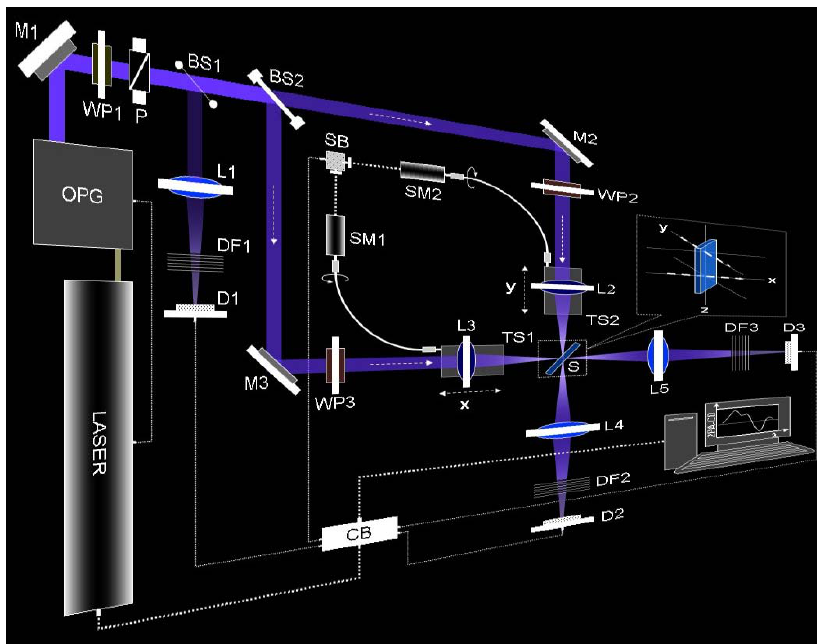
Figure 6. Experimental setup of the double L-scan. Between the laser system and mirror M1 more optical elements such as converging and diverging lenses, pinholes, optical filters, polarizers and waveplates were placed for beam expansion, collimation, spatial filtering, energy attenuation and polarization control. The power of the pump beam is attenuated and linearly polarized using a combination of an achromatic zero-order broadband (spectral range ≈ 400–700 nm) half-wave plate (WP1) and a broadband Glan polarizer (P). The beam splitter BS1 (10/90) is employed to constantly monitor a weak portion of the incoming laser light as an energy reference on a silicon detector (D1). The strongest fraction of the laser is separated into two identical beams using a broadband (50/50) beam splitter (BS2). The final alignment of the two beams is controlled by means of two broadband aluminum mirrors (M2 and M3). The polarization state of the incident beams after all reflective elements, is achieved by placing two achromatic zero-order broadband quarter-waveplates (400–700 nm), WP2 and WP3, before two achromatic convergent lenses, L2 and L3 (focal distance = 100 mm, w0 ≈ 11 μ m). L2 and L3 are moved simultaneously, with identical displacement x = y, and in the same direction on two individual translation stages (TS1 and TS2). TS1 and TS2 are simultaneously translated by coordinating two step-motors, SM1 and SM2, using a synchronization box (SB). Due to the experimental geometry, S is placed at a 45° angle with respect to the incident beams propagation axes, giving an effective path length equal to 1.4 mm (1 mm thickness cell). The two incident beams are approximately 1 cm apart on the vertical axis (inset) and both are parallel to the table. After the sample, L4 and L5 are utilized to fully collect the total energy of the beams into silicon detectors D2 and D3. Neutral density filters (DF1, DF2, and DF3) are used to adjust the input energy into the different detectors. The whole setup is synchronized and controlled with a control box (CB) and a LABVIEW program using a PC